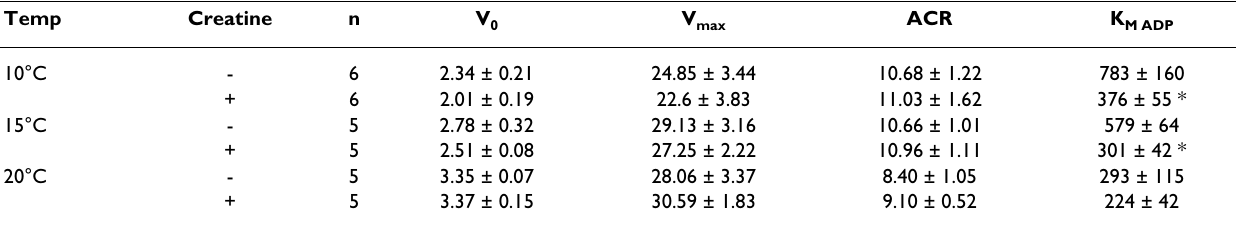
Table 3: ADP-kinetics of respiration in permeabilized fibres in fish R-solution Temp